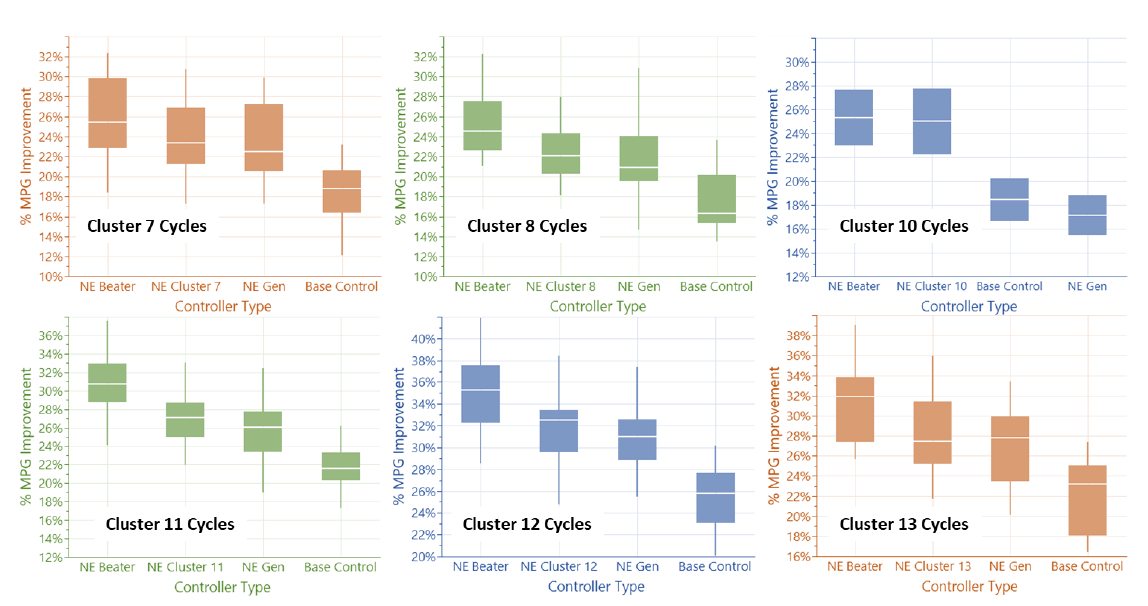
Figure A1. Controller performance comparison showing the improvement of the NE Cluster controller from the General NE controller. The remaining optimal gap is shown versus the NE Beater controller.